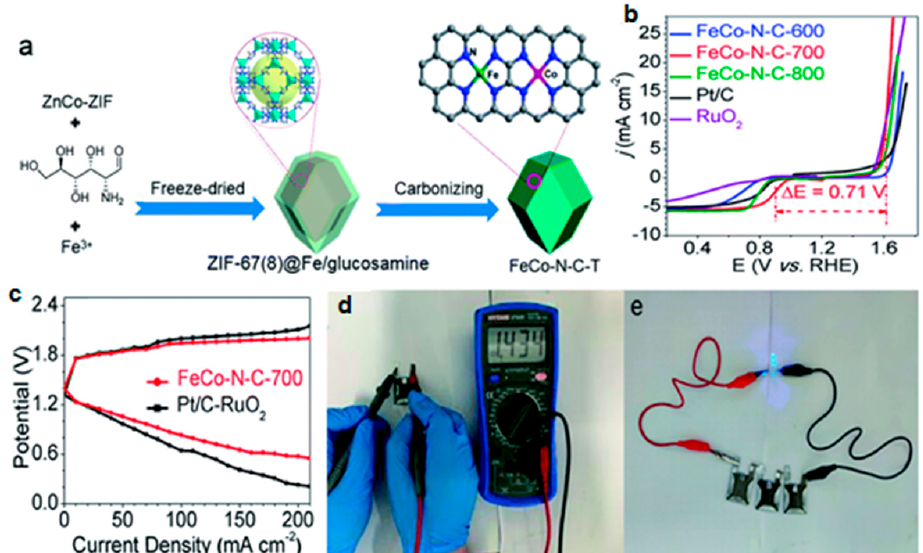
Figure 12. ( a ) Schematic illustration for the synthesis of FeCo-N-C-T; ( b ) ORR/OER bifunctional LSV curves of FeCo-N-C-T, Pt/C, and RuO 2 ; ( c ) Discharge/charge polarization curves of rechargeable ZABs using FeCo-N-C-700 and Pt/C + RuO 2 as the air electrode; ( d ) The open-circuit voltage of an all-solid-state ZAB; ( e ) The LED light powered by three all-solid-state ZABs. Copyright the Royal Society of Chemistry 2020 [109].